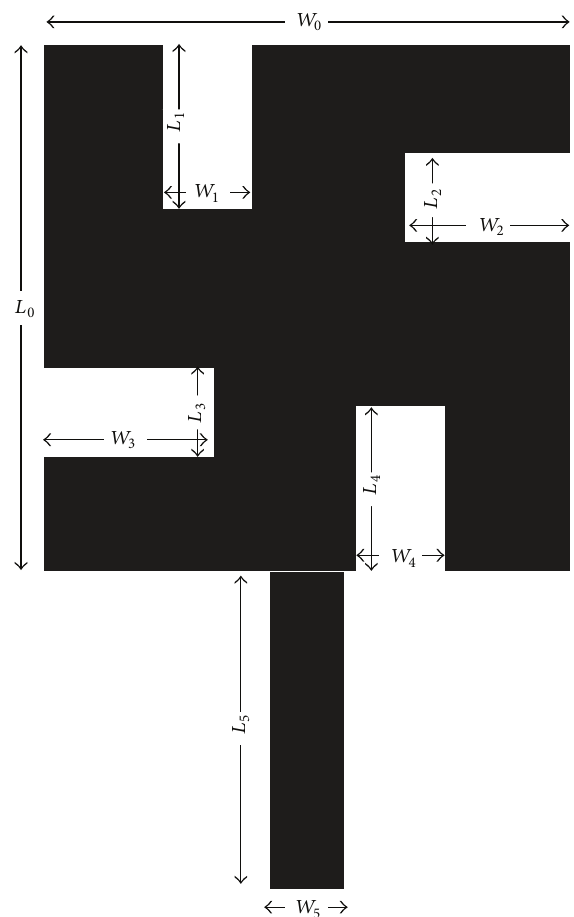
Figure 1: Design schematic of the radiating patch of the proposed